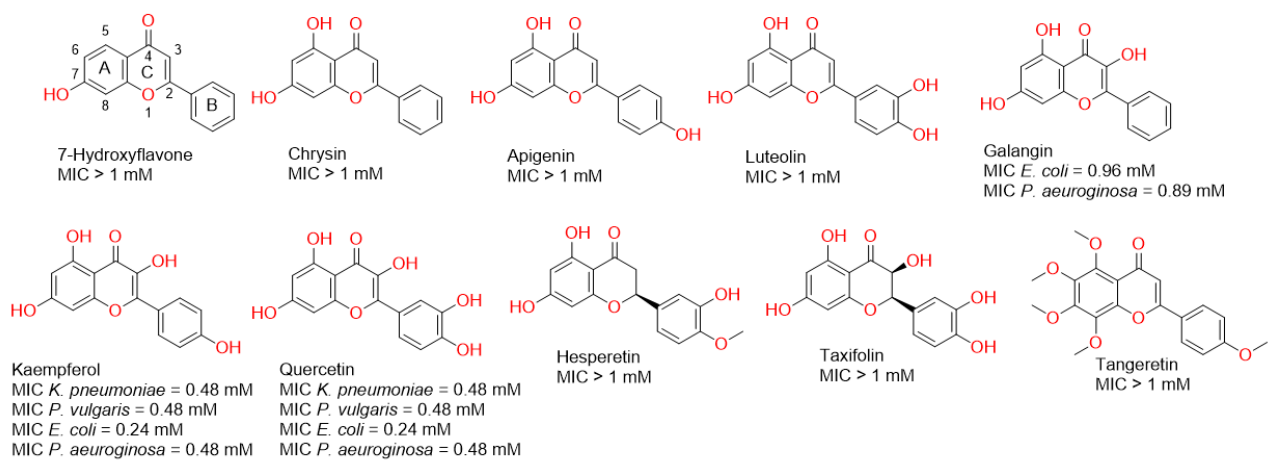
Figure 1. Structures of the tested flavonoids in the present study along with the antibacterial activity of each one against a number of Gram-negative bacteria.